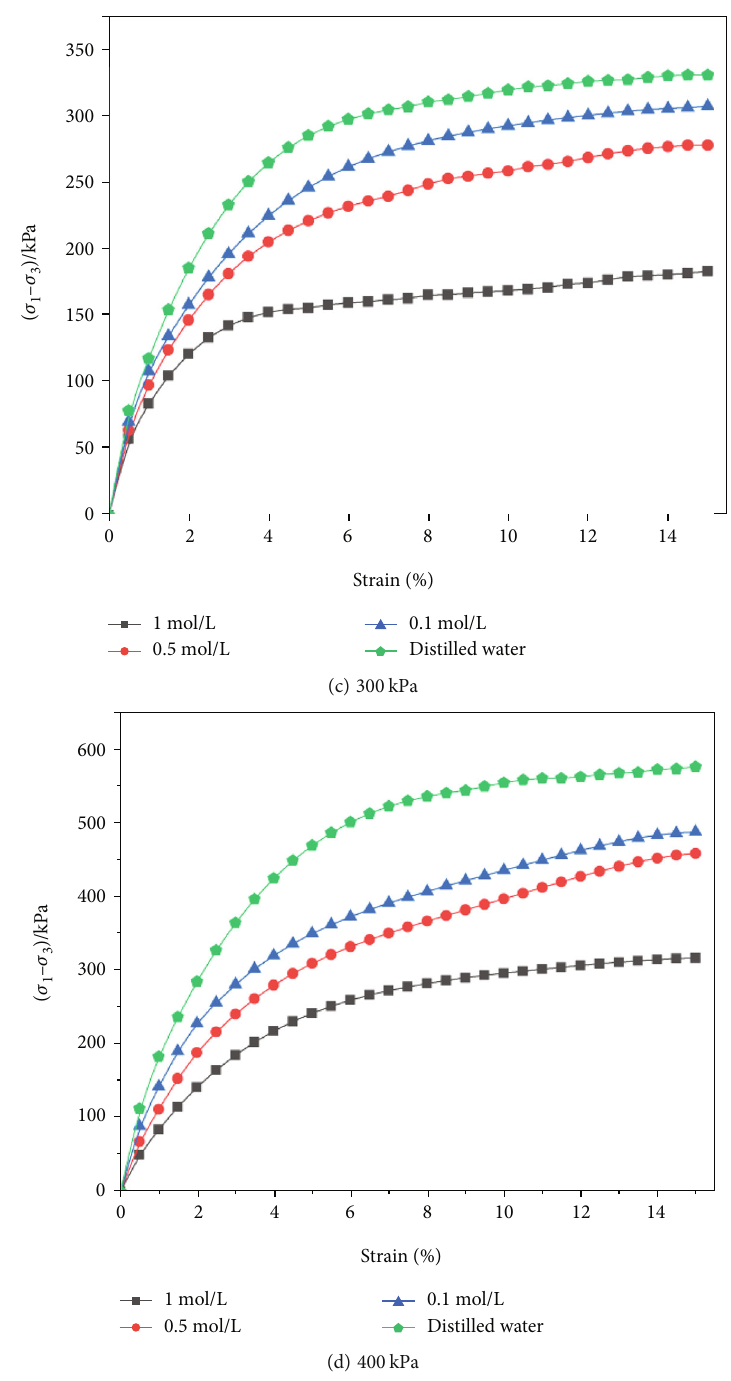
Figure 4: Stress-strain relationship curves of expansive soil due to di ff erent SLS solution